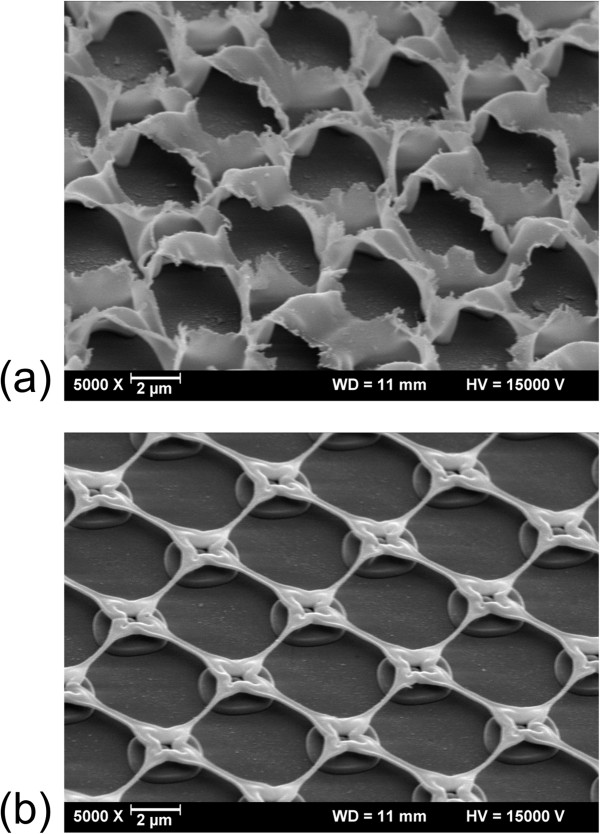
Influence of confinement. Patterned 150-nm-thick SiOx film irradiated (a) without and (b) with confinement (after peeling off the confinement layer); laser parameters: 248 nm, 260 mJ/cm2, 1 pulse.